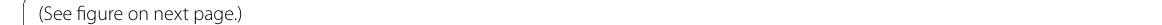
(See figure on next page.) Fig. 4 Imaging in early periantral inflammation. a Premaxillary and retroantral fat infiltration without bony erosion. b Bilateral premaxillary abscesses and intense enhancement of retroantral fat, masticator and infratemporal fossa with antral bony erosion. c Non-enhancing left half of anterior palate (*). d Early subperiosteal collection (arrow) and extraconal fat infiltration in supero-medial aspect of left orbit. e Enhancement of right optic nerve (thin white arrow), intraconal soft tissue extending till orbital apex (black arrow) and basitemporal meninges (thick white arrow). f Proptosis on right side with stretched optic nerve and distorted conical